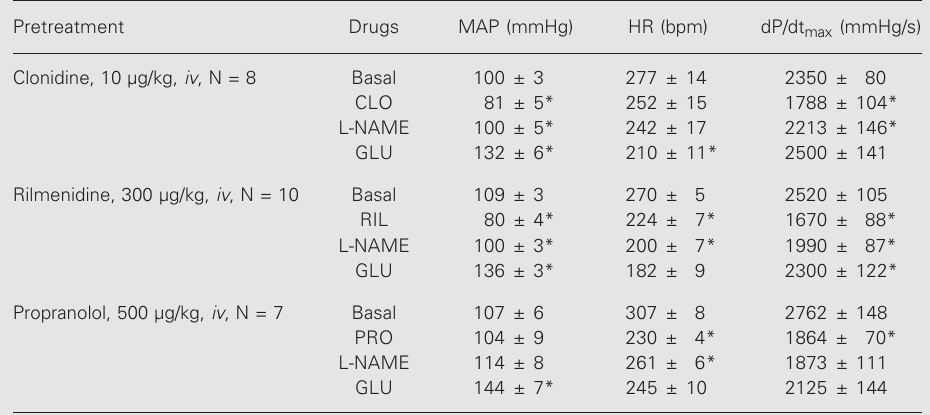
Table 1. Hemodynamic effects of intravenous ( iv ) administration of clonidine (CLO), rilmenidine (RIL) or propranolol (PRO) before injection of N (cid:2) -nitro-L-arginine methyl ester (L-NAME, 40 mg/kg, iv ) and L-glutamate (GLU, 10 µmol, icv ) in pentobarbital-anesthetized